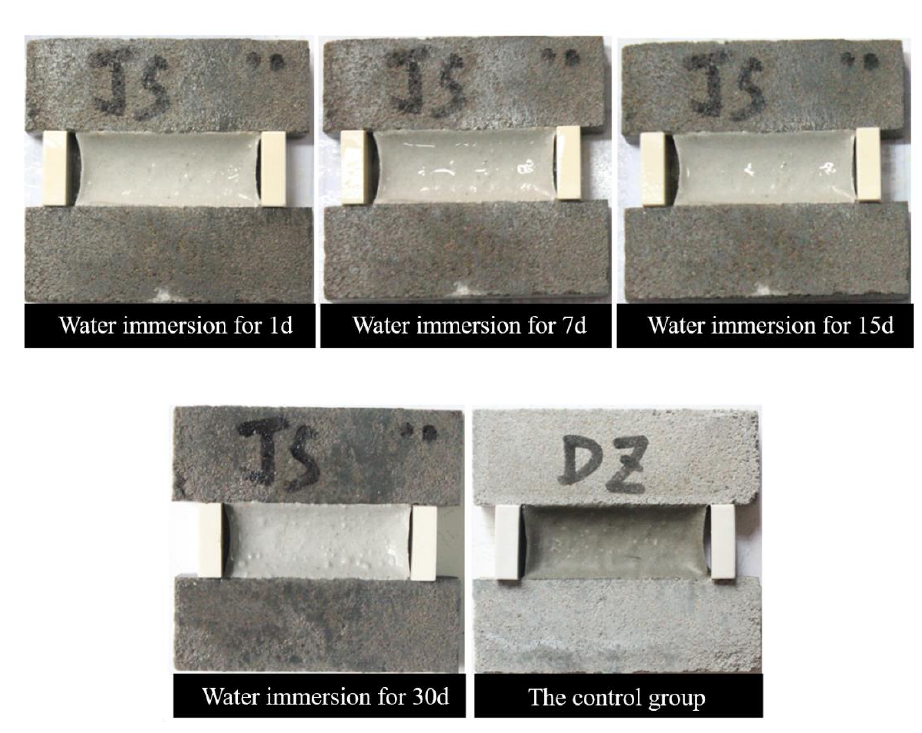
Figure 5. Fixed elongation morphology characteristics of PCFC under different water immersion time.